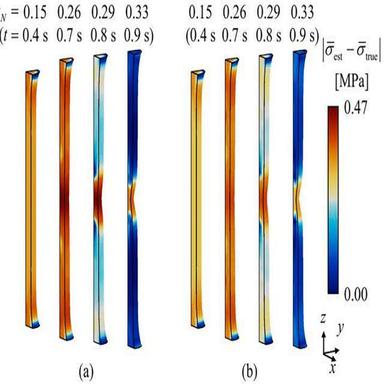
Distributions of the absolute errors of the equivalent stress at εN = 0.15, 0.26, 0.29, and 0.33 (i.e., t = 0.4, 0.7, 0.8, and 0.9 s) between σtrue obtained from the virtual experiment and σest obtained from the simulation using the optimal parameters estimated by En4DVar when the synthetic observation data of the displacement and strain are extracted (a) over the entire surface (reference case) and (b) around the diffuse-necking region (Case A).